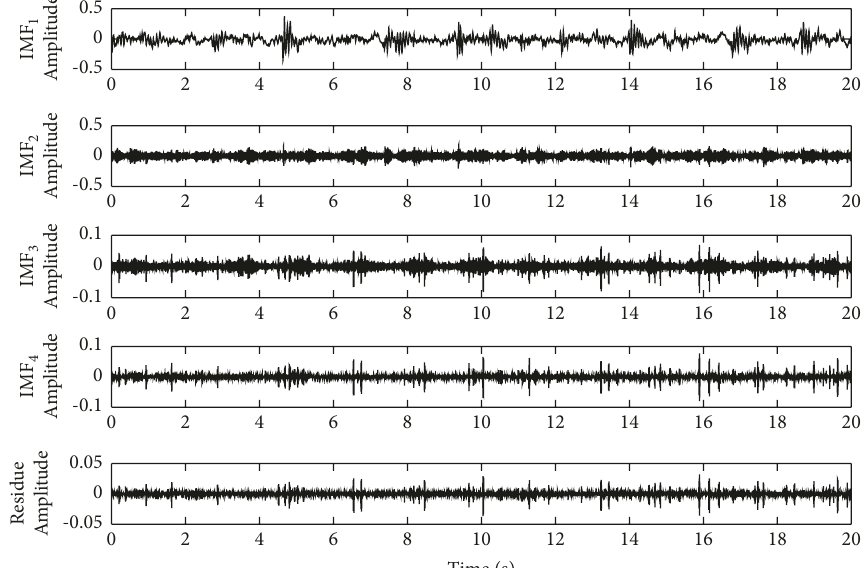
Figure 10: The decomposition results generated by VMD of a vibration signal from class 3.